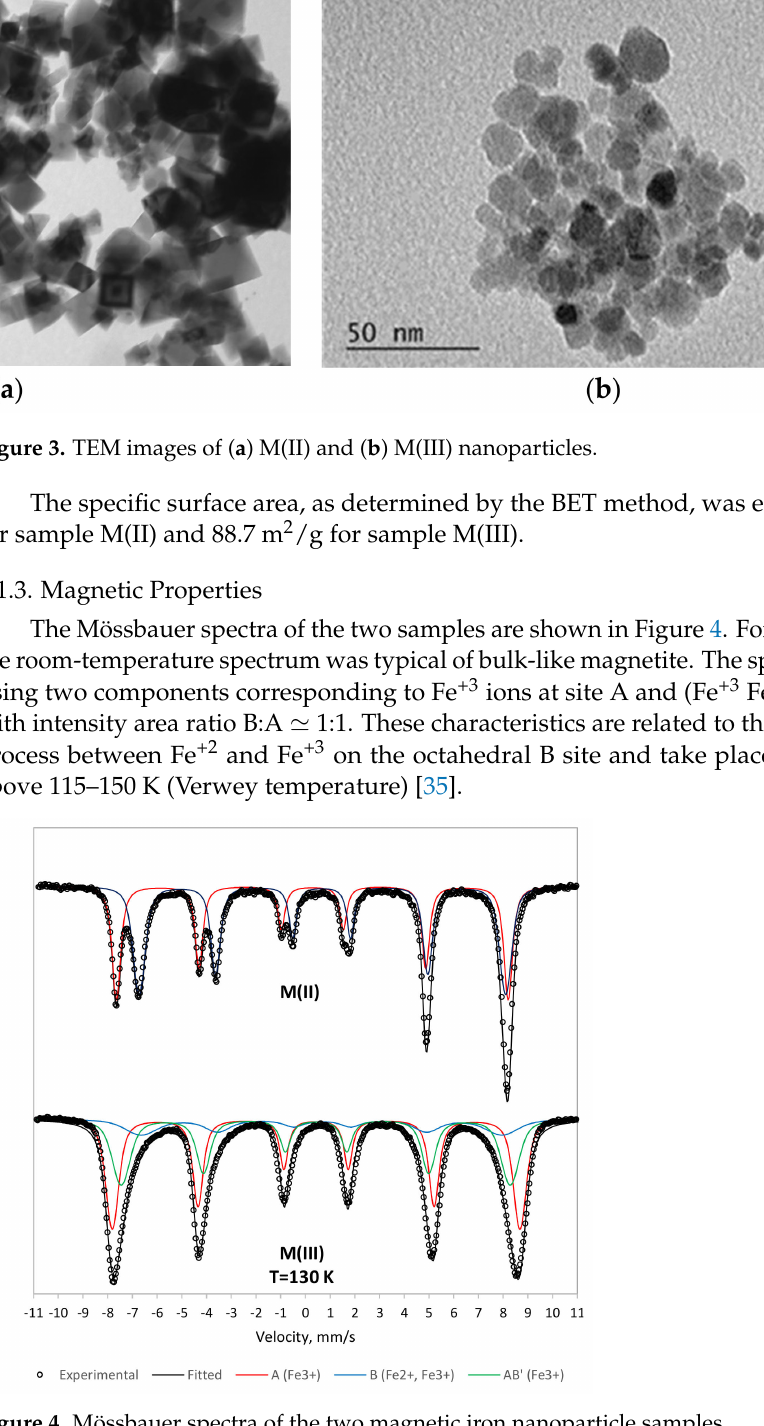
Figure 4. Mössbauer spectra of the two magnetic iron nanoparticle